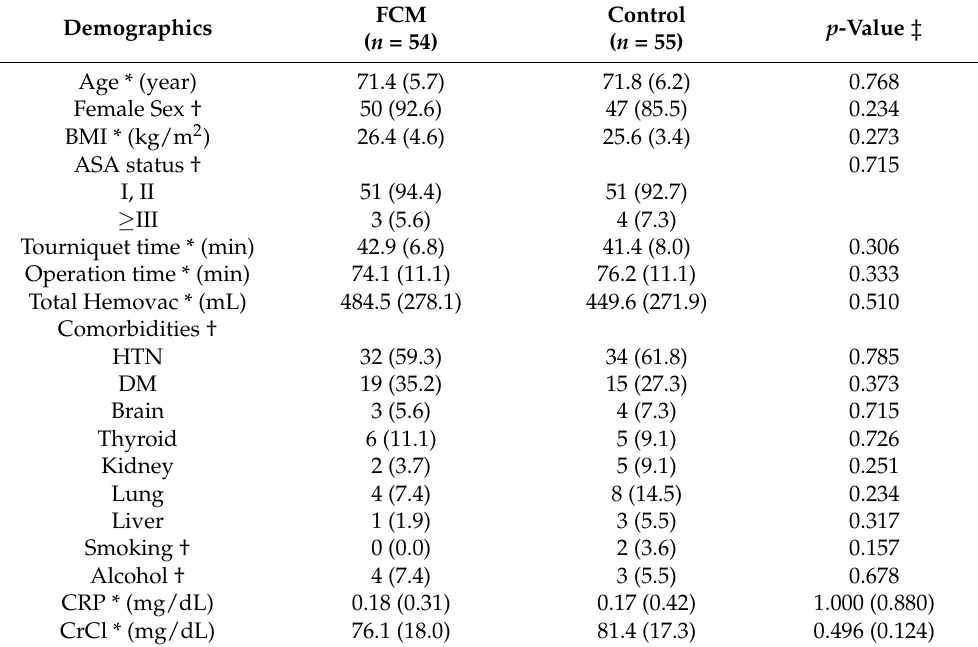
Table 1. Patient Demographics and Preoperative